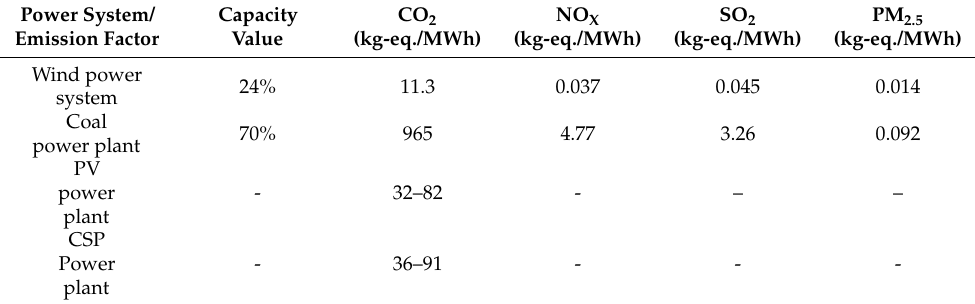
Table 3. Result assessment of wind and coal